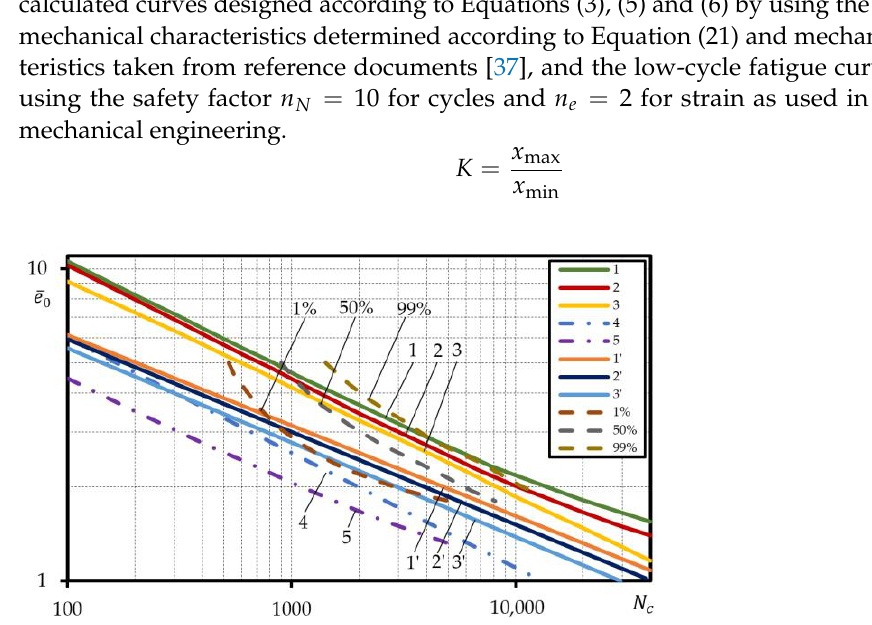
Figure 11. Comparison of the probabilistic low-cycle fatigue curves calculated under strain-con- trolled loading with the experimental ones for steel 15Cr2MoVA; straight lines — calculated, dashed loading with the experimental ones for steel 15Cr2MoVA; straight lines—calculated, dashed lines– lines – experiment; normalized characteristic according to: 1 — Equation (3), 2 — Equation (5), 3 — experiment; normalized characteristic according to: 1—Equation (3), 2—Equation (5), 3—Equation (6); Equation (6); reference characteristics, according to: 1′—Equation (3), 2′—Equation (5), 3′— Equation reference characteristics, according to: 1 (cid:48) —Equation (3), 2 (cid:48) —Equation (5), 3 (cid:48) —Equation (6); calculated, (6); calculated, according to: 4 — Equation (3) 𝑛 𝑒 = 2, 5 — Equation (3) 𝑛 𝑁 = 10 . according to: 4—Equation (3) n e = 2, 5—Equation (3) n N = 10.